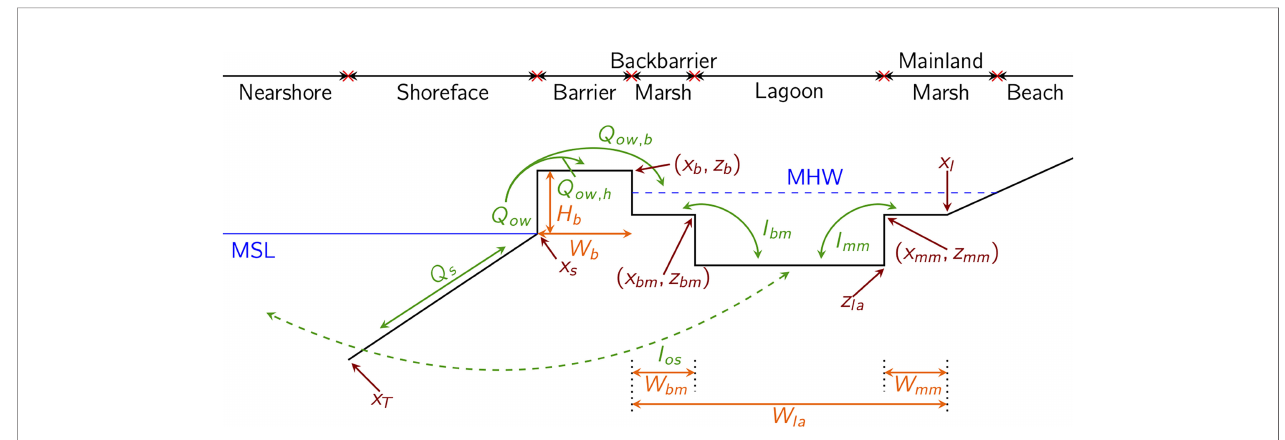
FIGURE 1 | Setup for the Lorenzo-Trueba-Mariotti model with the simpli fi ed geometry of the BLM system. The red crosses mark the locations for the governing equations with the names of some of the variables in red. Important fl uxes are given in green, while important measures, such as the barrier width and height (for example) are depicted in orange. Modi fi ed after Lorenzo-Trueba and Mariotti (2017).